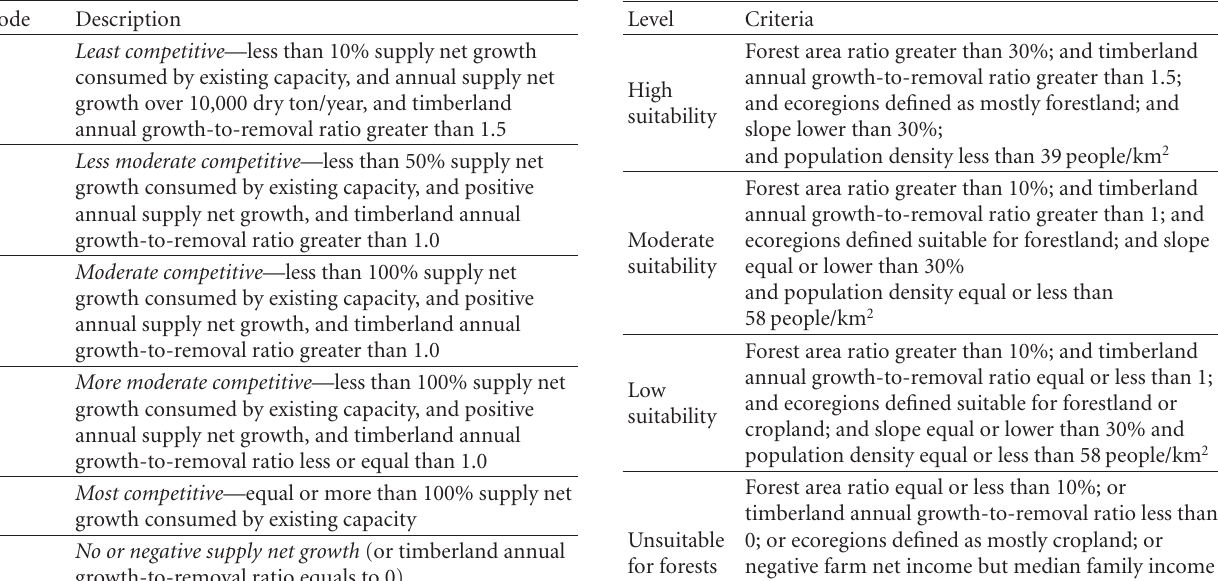
Table 3: Definitions of competition index on resource utilization. Table 4: Criteria for four levels of landscape